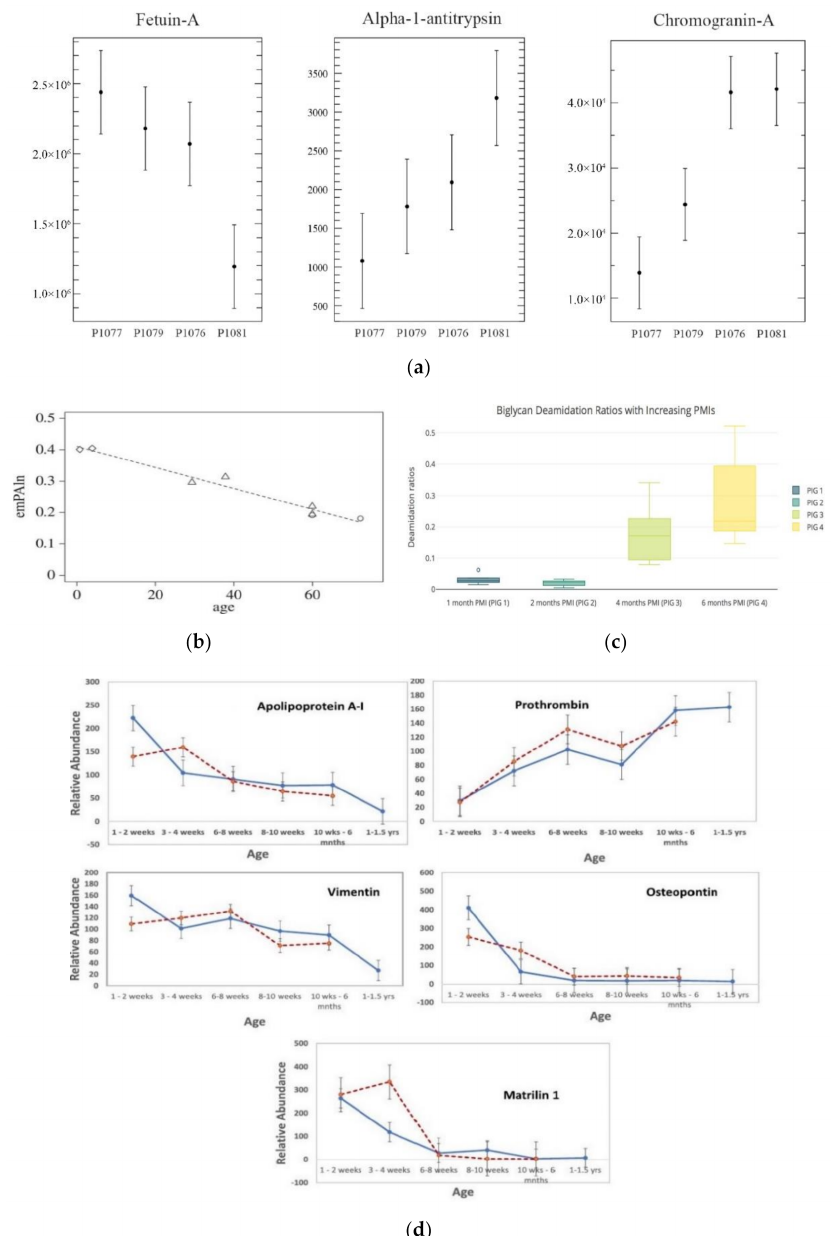
Figure 3. Applications of bone proteomic analysis for estimation of biological age and post-mortem interval (PMI). ( a ) Boxplots of relative abundances of fetuin-A (AHSG), alpha-1-antitrypsin, and chromogranin-A in proteomic analysis of porcine tibia midshaft samples with varying biological age of pigs (P1077—12 days old, P1079—28-days old, P1076—43-days old, and P1081—10-months old). Figure was adapted with permission from [40]. Copyright (2017) American Chemical Society. ( b ) Relationship between age and the normalized emPAI value of alpha-2-HS-glycoprotein (AHSG), Pearson’s r = − 0.9826, p -value = 1.295 × 10 − 5 . Symbols are (cid:3) (infant), (adult female), and ∆ (adult male). Figure was reprinted from [42], (cid:35) under the terms of the Creative Commons Attribution License (CC BY 4.0) https://creativecommons.org/licenses/by/4.0/ (accessed on 3 March 2021). ( c ) Box plot representing deamidation ratios calculated for the four tibias collected after one, two, four, and six months PMI. Each box represents five replicates that have been analyzed per individual. Figure was reprinted from [29], Copyright (2018), with permission from Elsevier. ( d ) Average abundance (calculated using label-free quantification) of apolipoprotein A-1, prothrombin, vimentin, osteopontin, and matrilin-1 for male (blue solid lines) and female (red dashed lines) rats (1 week—1.5-years old). Figure was adapted with permission from [148]. Copyright (2020) American Chemical